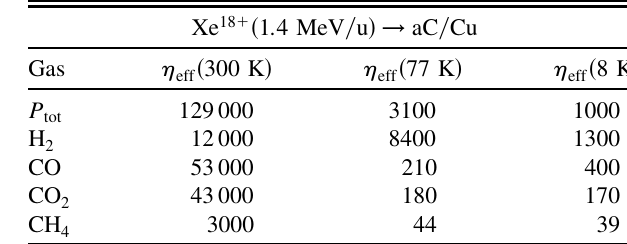
TABLE II. Heavy-ion-induced desorption yields calculated from the total and partial pressure rises for the aC = Cu sample, continuously bombarded under (cid:2) ¼ 0 (cid:2) with 1 : 4 MeV = u Xe 18 þ ions.